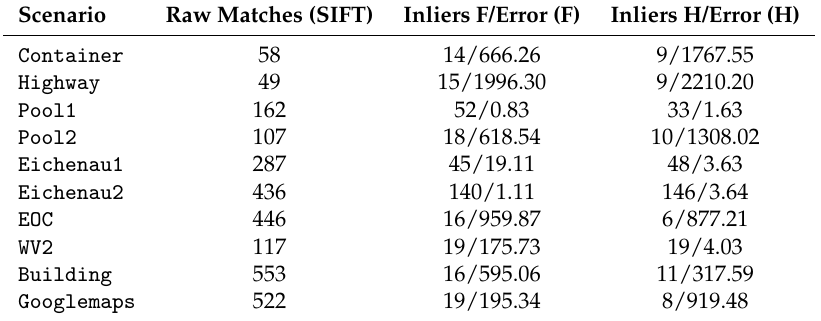
Table 7. Results using standard SIFT: number of raw matches after applying SIFT for all scenarios. Inliers after estimating the fundamental matrix (F) and homography (H) using RANSAC. Mean errors (in pixel) according to ground-truths F and H.